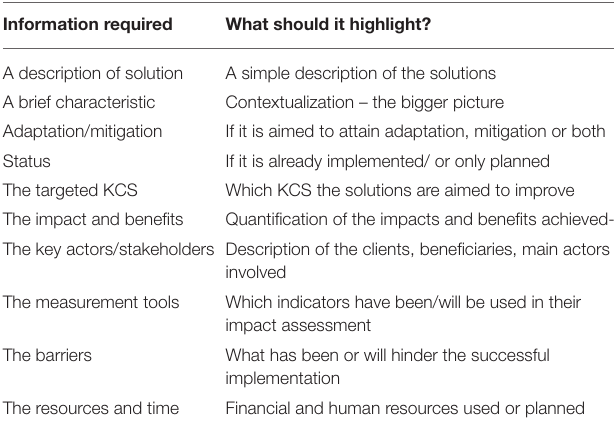
FIGURE 2 | Economic model of rational decision making.